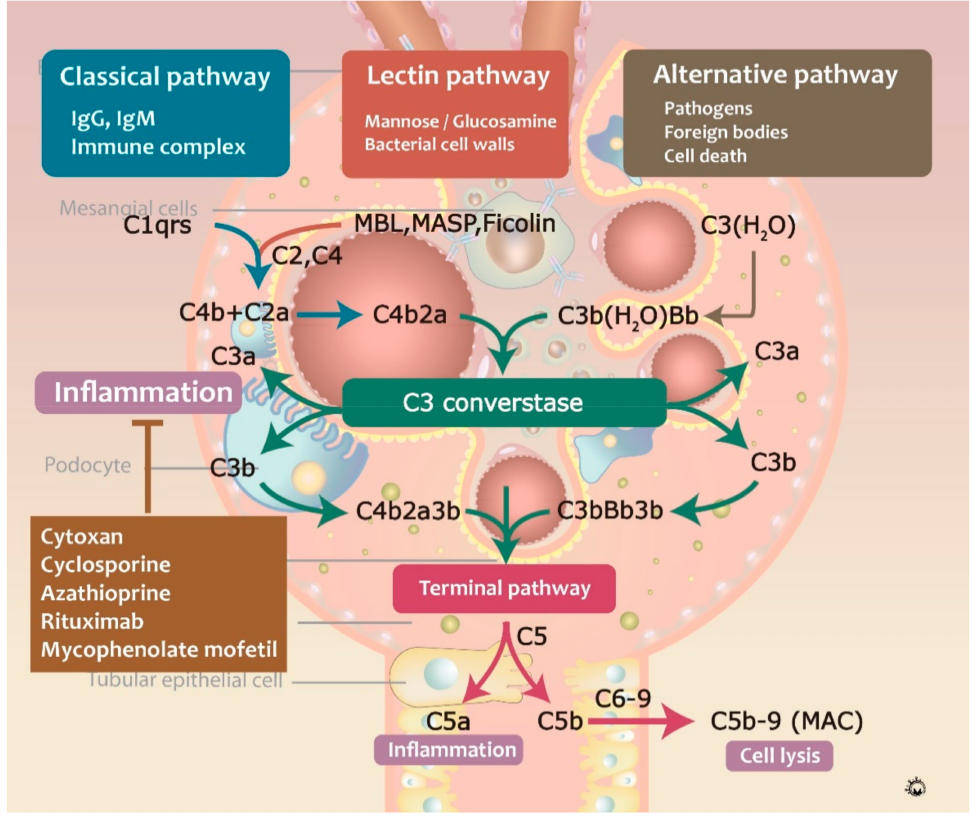
Figure 5. The mechanism of complement activation pathways in